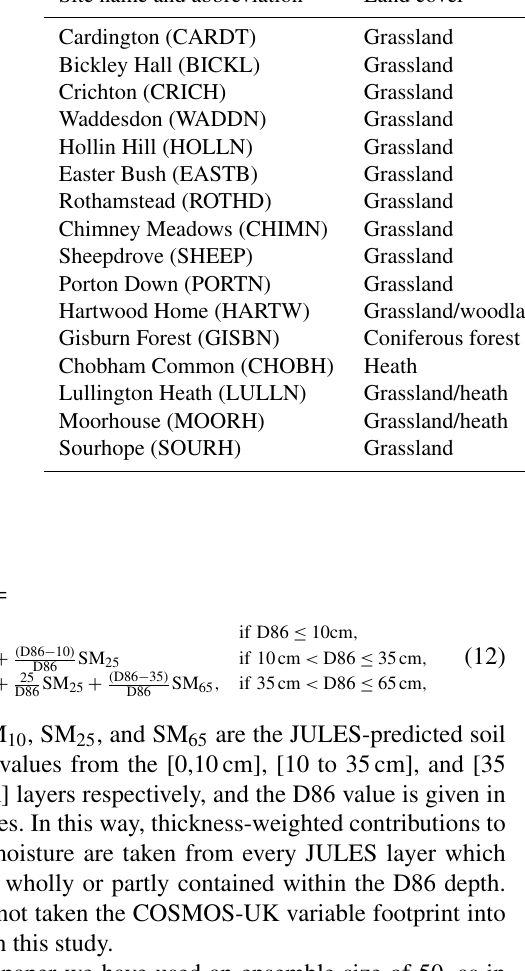
Table 3. COSMOS-UK sites selected for this study. “Heath” indicates some shrubs are present at the site. Site name and abbreviation